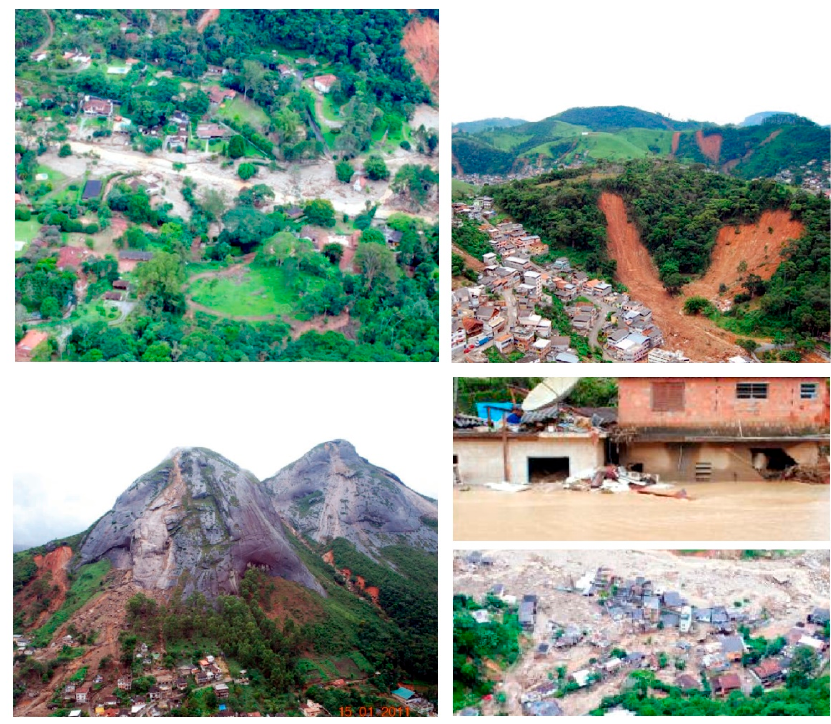
Figure 5. Photos from the 2011 disaster in the mountainous region of the Rio de Janeiro. Source: Reprinted/adapted with permission from Ref. [21]. 2012. Banco Mundial; Ref. [25]. 2011. DRM-RJ.